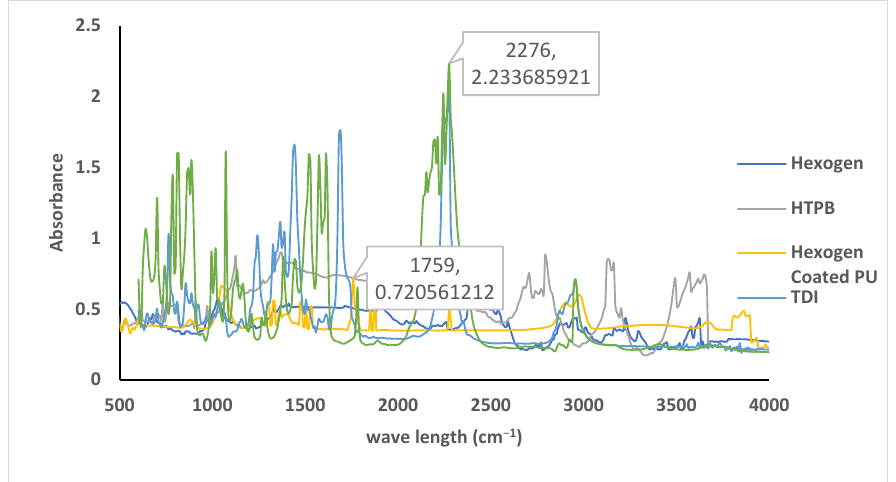
Figure 3. The spectra of ethyl acetate, HTPB, TDI, hexogen, and coated hexogen. 3.2. The Measurement of Isocyanate and Diazene Oxide Concentration The concentration of isocyanate solution was analyzed by plotting the infrared ab- sorbance at a wavelength of 2276 cm − 1 and extrapolation to the isocyanate calibration curve. Quantitative infrared spectroscopy analysis applied a standard liquid cuvet sampler for the Prestige FTIR diameter of 1 cm. The conversion of the absorbance to the concentration used the Beer law, in which the spectra absorbance is linear to their concentration if the other parameters are constant. Figure 4 illustrates the isocyanate calibration curve, where the absorbance value was linear to their isocyanate concentration and was expressed by the equation Abs = 0.1726 CNCO − 0.0053 with an R 2 value = 0.9986. These linear relationships showed no significant interference and could be used for quantitative analysis.